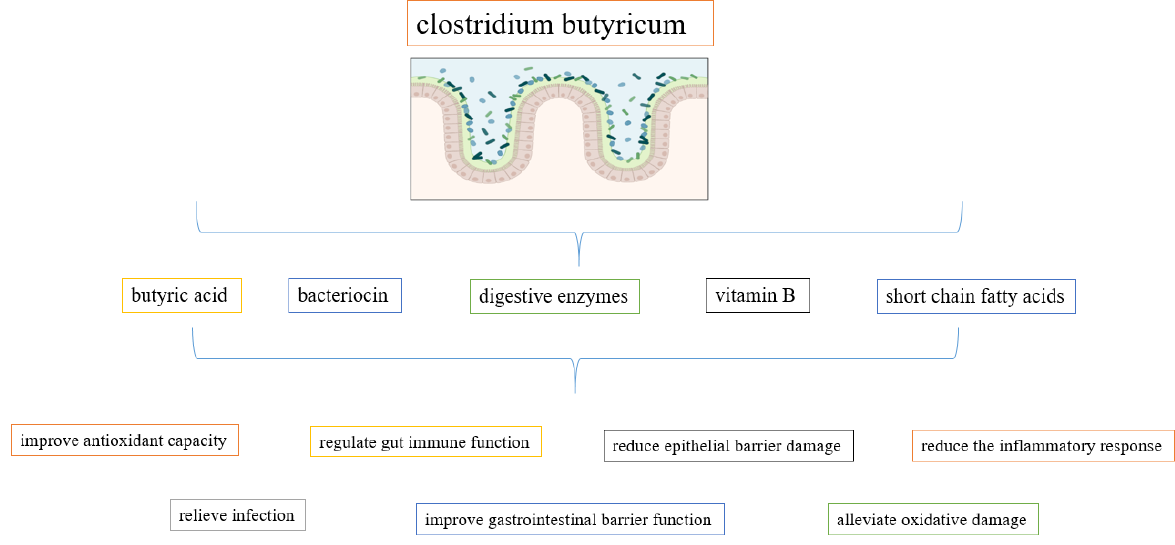
Figure 1. Metabolites and beneficial effects of C. butyricum.